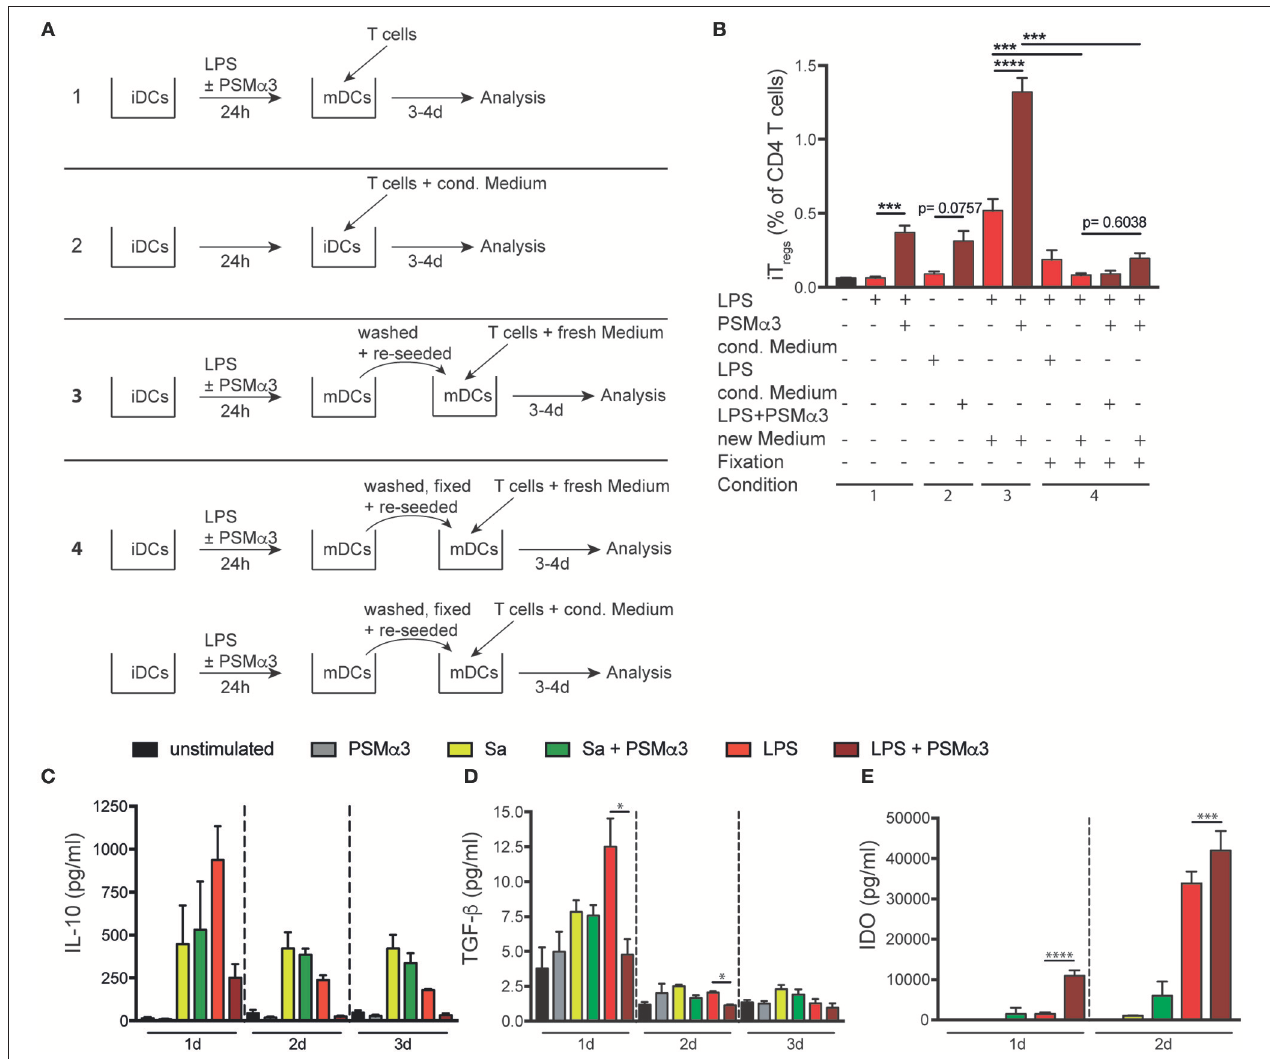
FIGURE 6 | PSM α 3-treated moDCs increase the proliferation and frequency of iT regs by direct interaction and IDO production. (A) Schematic overview of the experimental setting: T cells were co-cultured for 3–4 d (1) with mDCs (LPS or LPS + PSM α 3 for 24h), with (2) untreated moDCs (iDCs) in the presence of conditioned medium from LPS or LPS + PSM α 3 treated DCs, with ( 3) washed and re-seeded mDCs together with new medium or (4) with fixed moDCs together with either new medium or conditioned medium. (B) The bar graphs show the frequency of iT regs from CD4 + T cells analyzed by flow cytometry from the experiments described in (A) (one representative of n ≥ 3 independent experiments performed in triplicates). (C,D) Cell culture supernatants from the DC T cell co-culture ( n ≥ 3 performed in triplicates; mean ± SEM) were analyzed for IL-10 (C) and TGF- β production (D) after 1 d, 2 d or 3 d by a bead-based immunoassay. (E) Cell culture